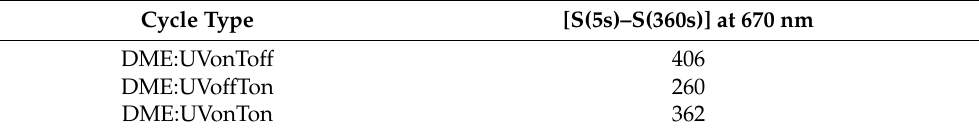
Table 4. Results in band 670 nm of ultra-short-term test for RDFU(s) degradation in the DME cycle. Cycle Type